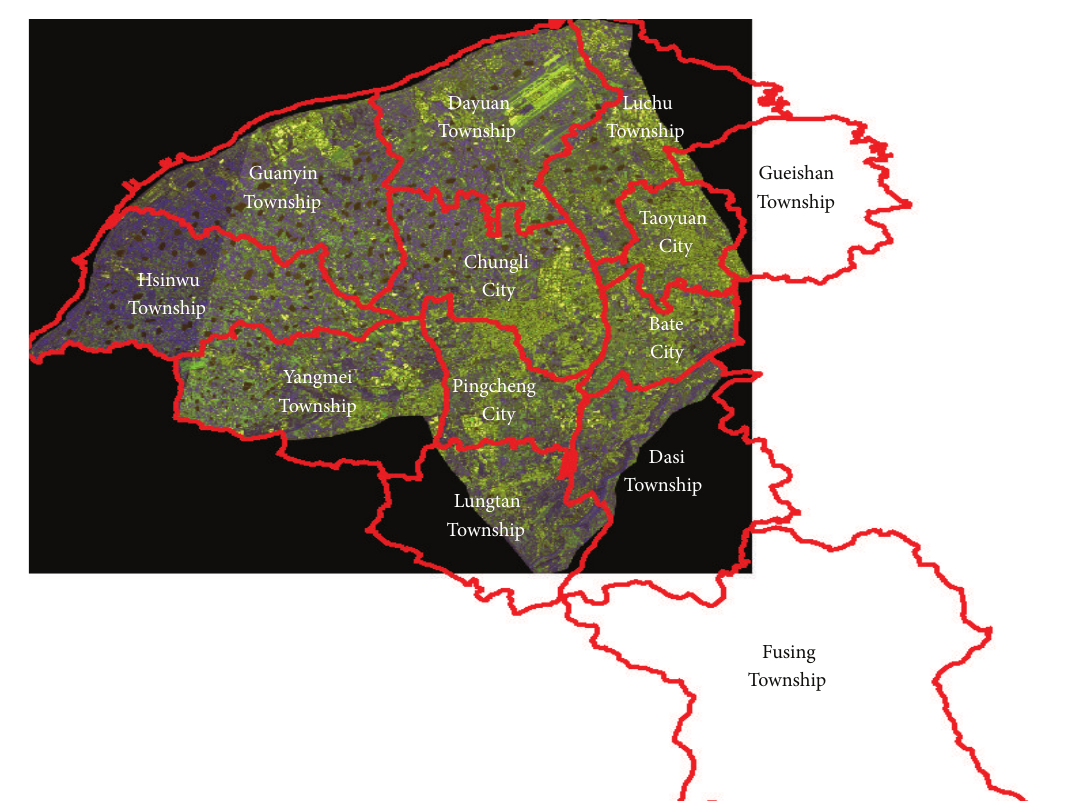
Figure 2: Preprocessed study area (excluding highlands (forest) and reservoir (water